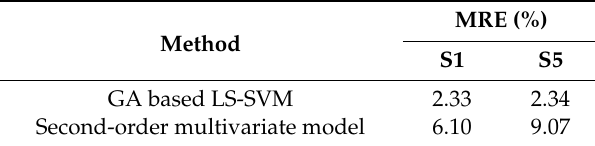
Table 8. The comparison of predicted MRE for different methods.